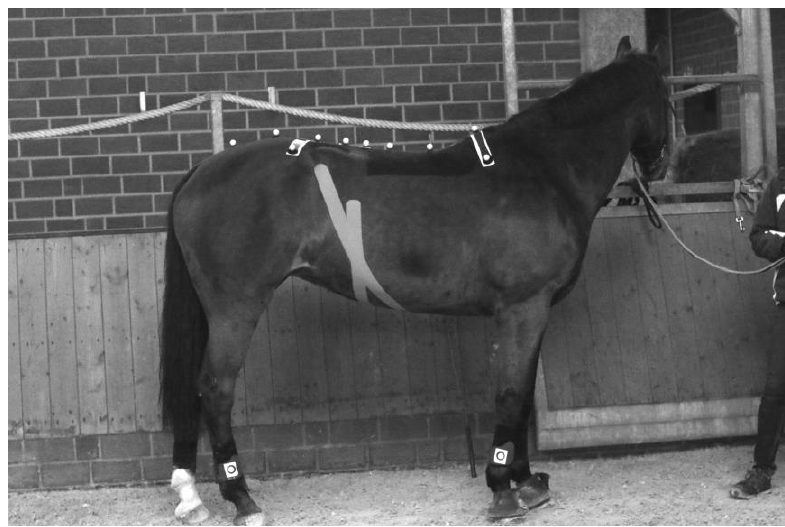
Figure 1. Position of the reflective markers on the horse at T6, T12, T15, T18, L3, L5, tuber sacrale, S3 and bilateral markers on T6 and tuber coxae. Please note that lateral markers of T12 and T15 are missing on the photo. Markers placed on the limbs were not used for analysis in this study.